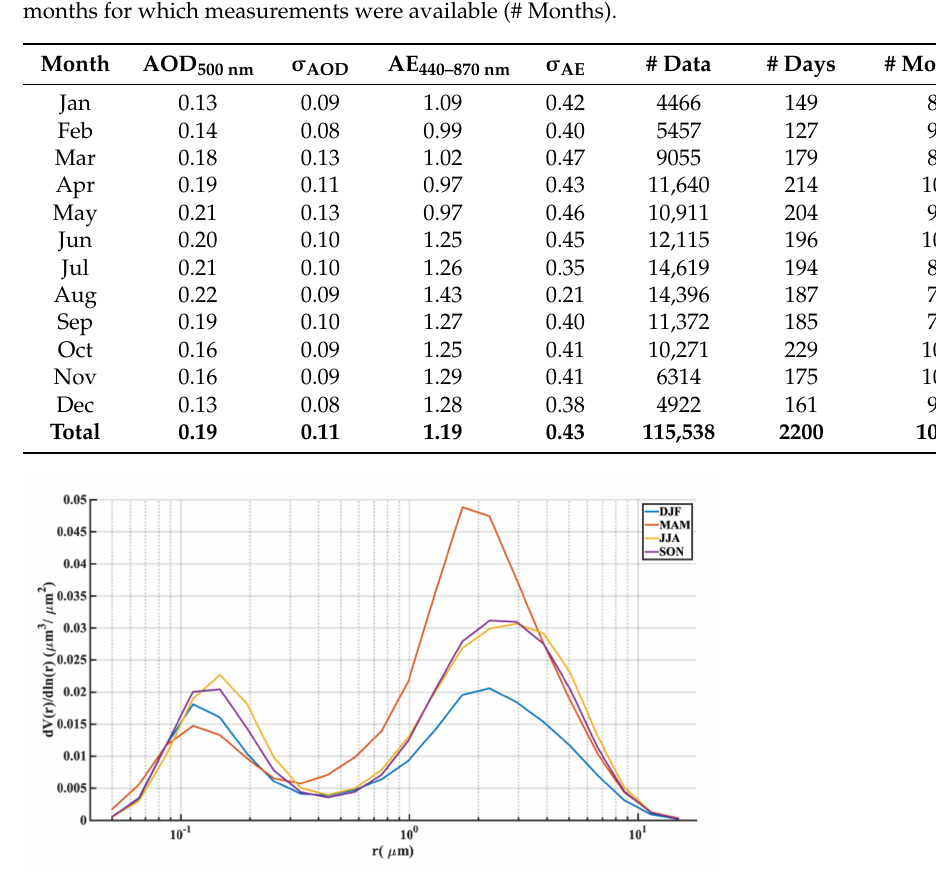
Table 2. Climatology of AOD and AE as derived from level 2.0 and level 1.5 version 3 AERONET